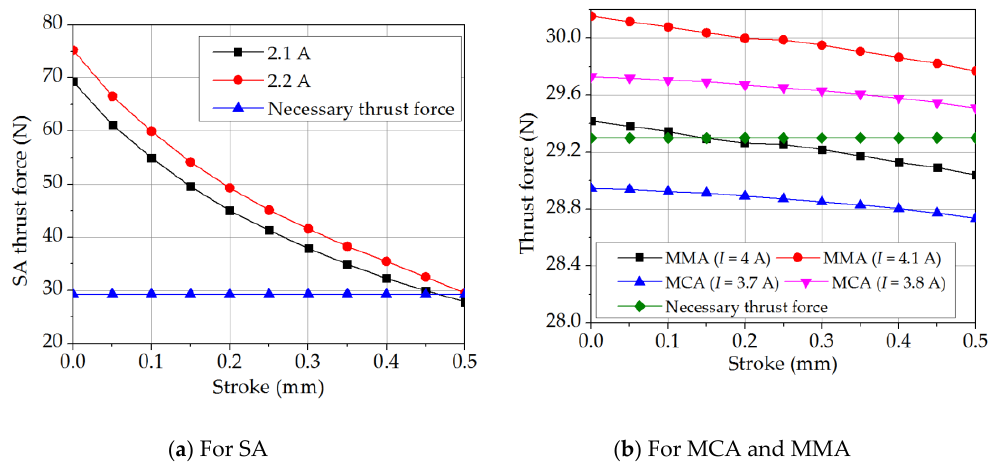
Figure 15. Minimum excitation current for ( a ) SA, ( b ) MCA, and MMA models (with return spring).